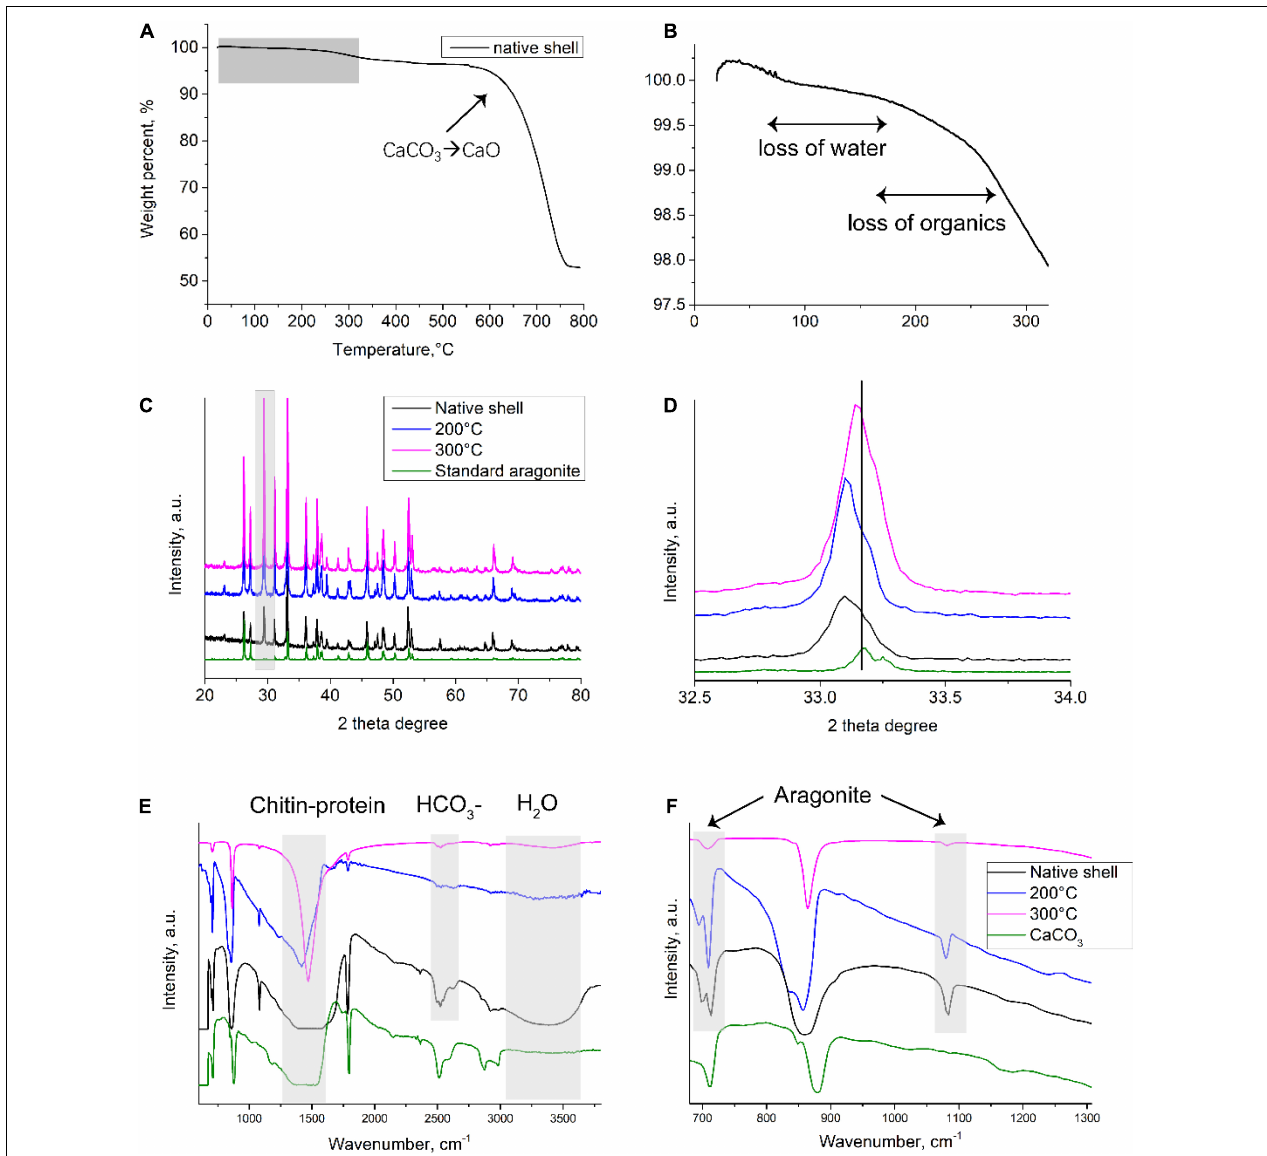
FIGURE 4 | Compositional analysis of native and toasted abalone shell. (A) TGA analysis of native shells and a close look at room temperature to 300 ◦ C (B) . XRD patterns (C) and a close exanimation of (012) peaks (D) ; FTIR spectroscopy (E) and a close examination from wavenumbers at 650–1,300 cm - 1 (F) .